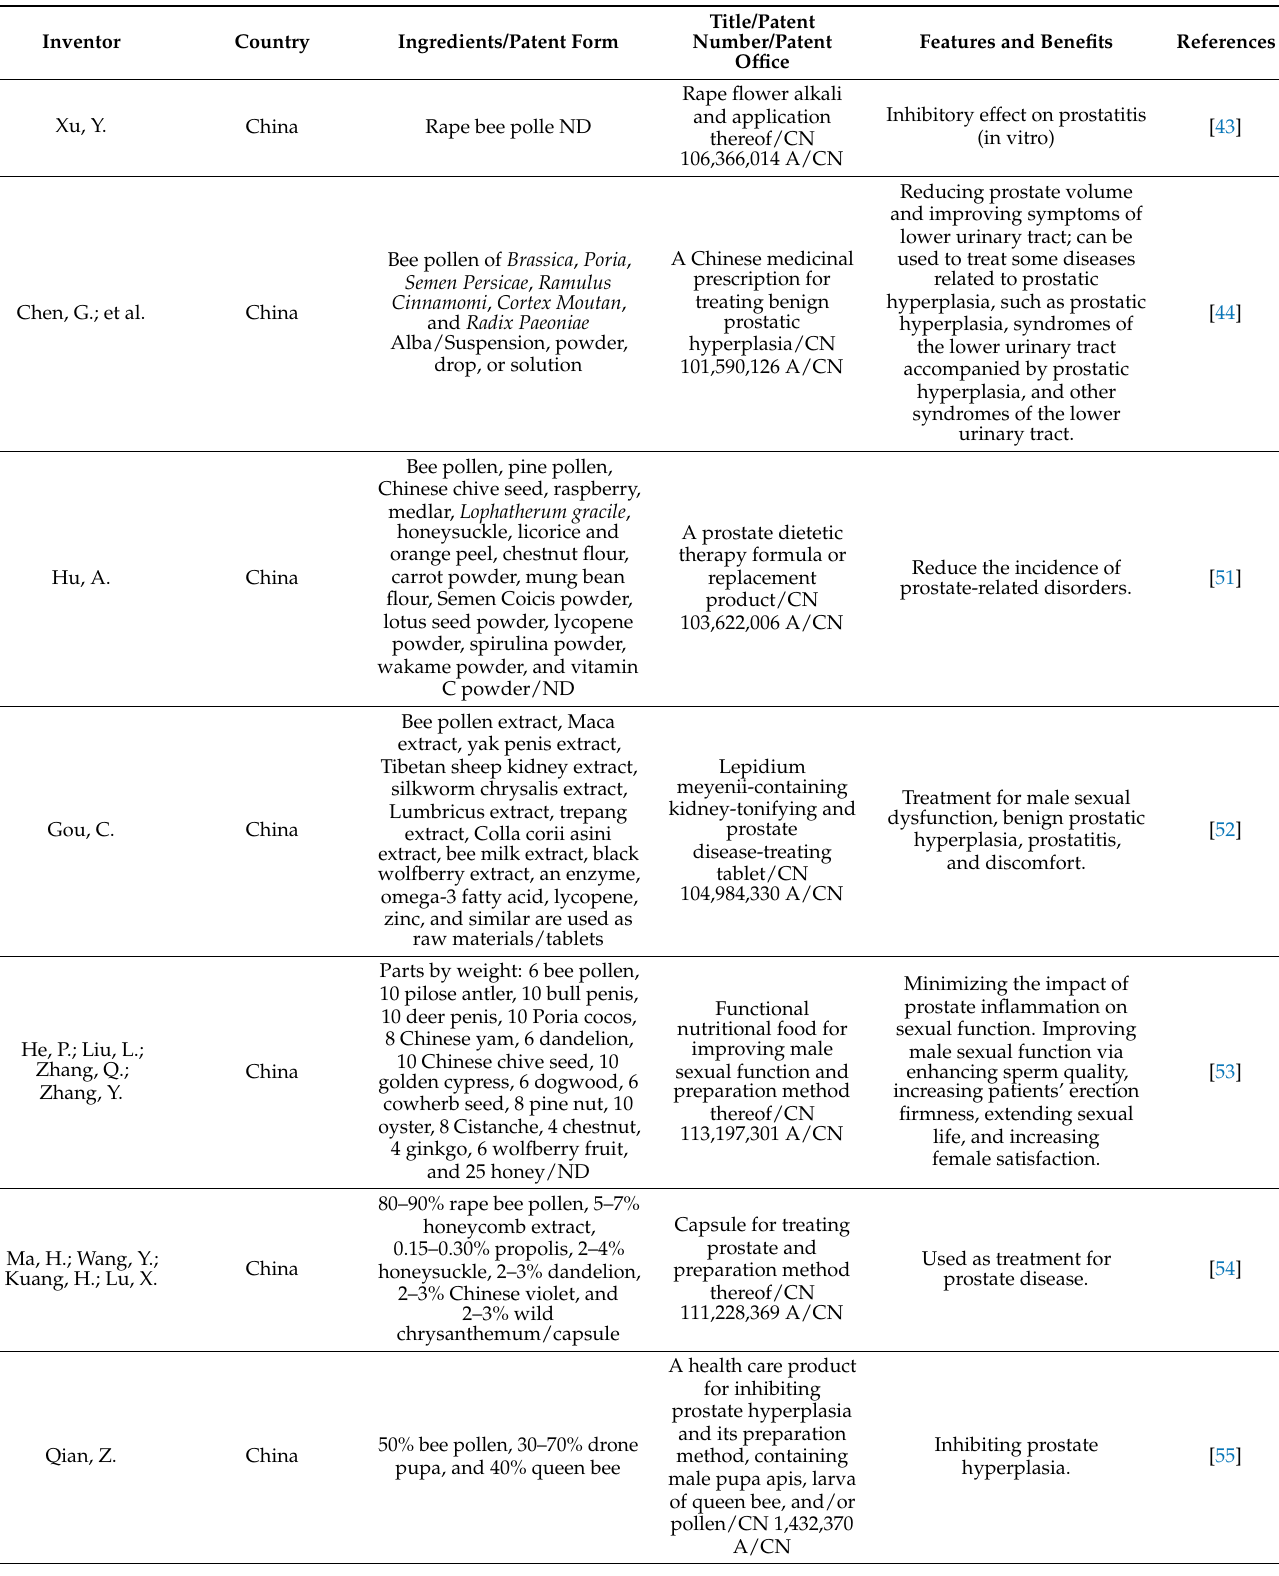
Table 1. Bee pollen formulations to improve prostatic